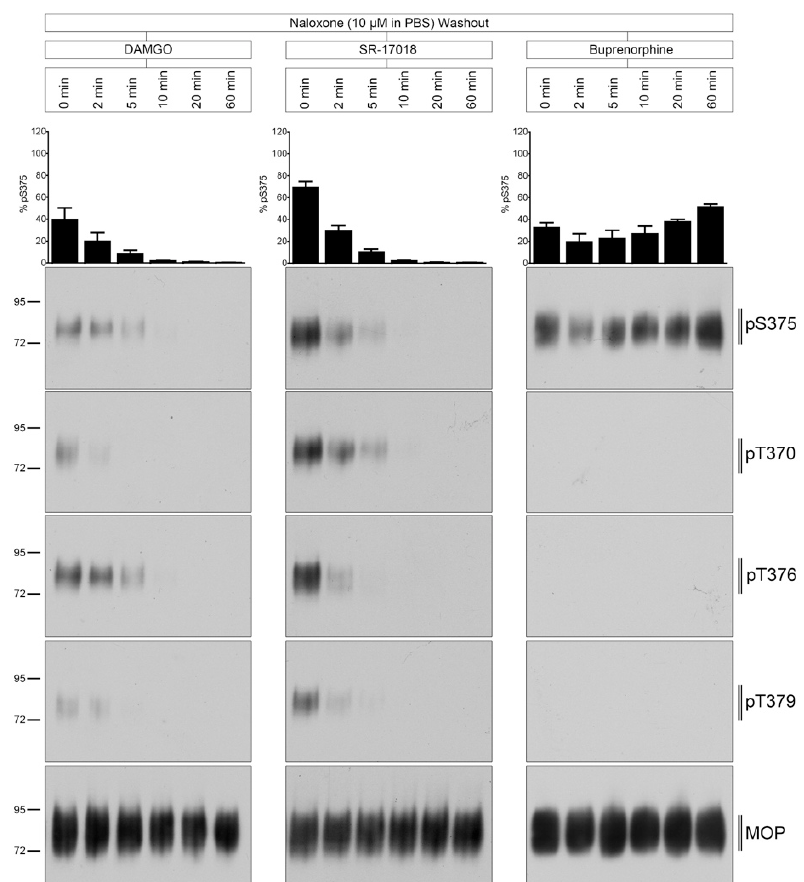
Figure 5. Time course of multisite dephosphorylation after naloxone washout. HEK293 cells stably expressing HA-MOP were incubated with (left panel) 10 µM DAMGO, (middle panel) 10 µM SR-17018, or (right panel) 10 µM buprenorphine for 30 min at 37 °C. Cells were washed three times with 10 µM naloxone and then incubated in the absence of agonist for 0, 2, 5, 10, 20, or 60 min at 37 °C. Cells were lysed and immunoblotted with the anti-pT370 (pT370), anti-pT376 (pT376), anti-pT379 (pT379), or anti-pSer375 (pS375) antibodies. Blots were stripped and reprobed with the phosphorylation-independent anti-HA-tag antibody to confirm equal loading of the gels (MOP). S375 phosphorylation was quantified (upper panel) and expressed as percentage of maximal phosphorylation in control cells, which was set at 100% (data not shown). Data correspond to mean ± SEM from at least three independent experiments. Positions of molecular mass markers are indicated on the left (in kDa). Blots are representative of three independent experiments.